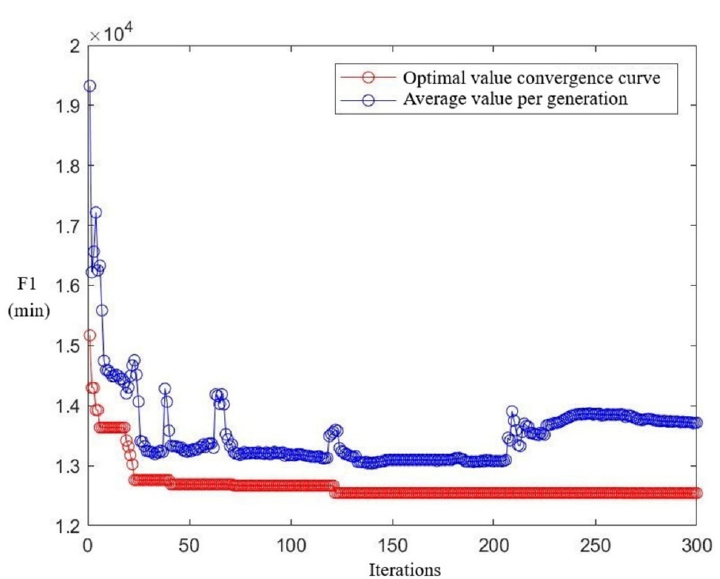
Figure 7. Optimal value convergence curve of total scheduling time and average value curve of each generation.